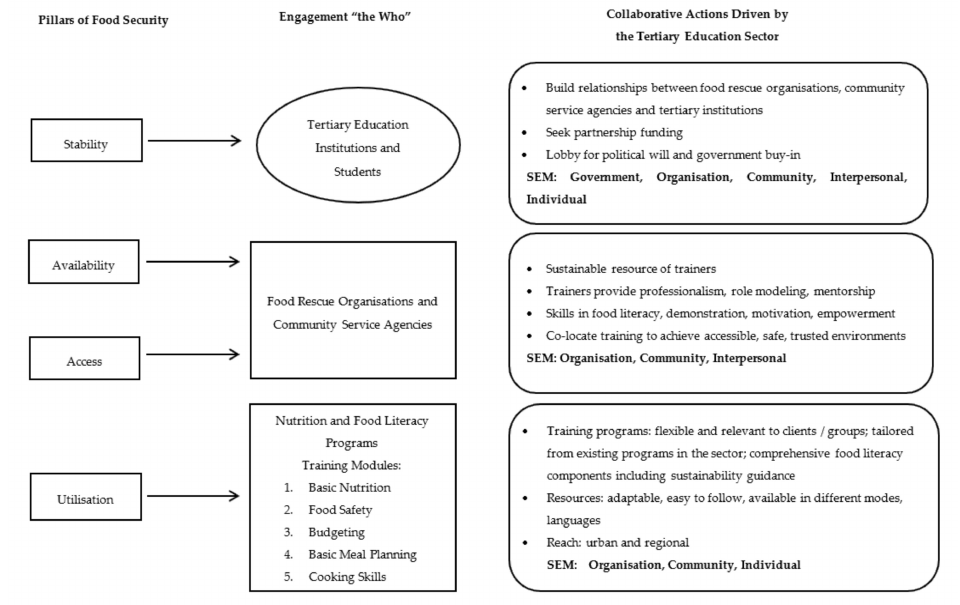
Figure 1. Food Action Logic Model: A schematic representation of collaborative actions driven by the tertiary education sector to address engagement with food rescue and community service organization’s to improve food security via a food literacy education model. SEM: Socio-ecological